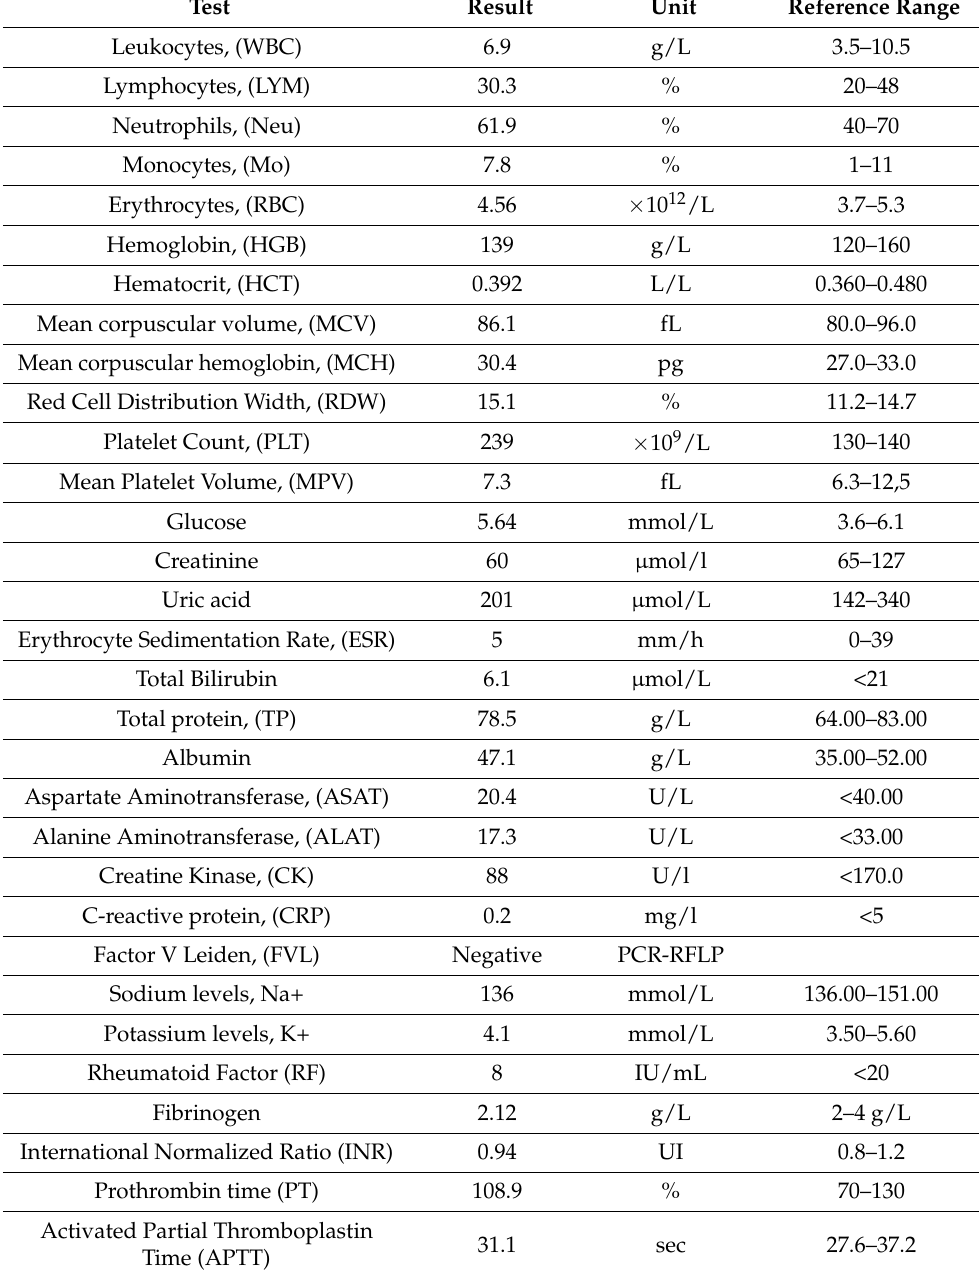
Table 1. Standard blood screening test results of 43-year-old woman. The data does not show deviations from the reference